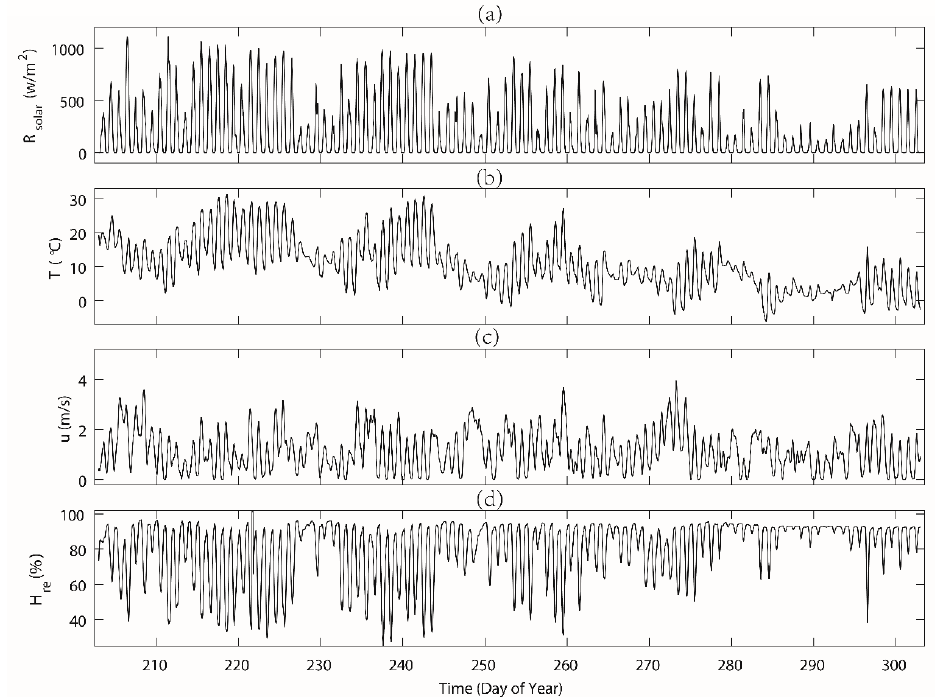
Figure 4. The measured micro-meteorological variables at hourly intervals during the day of year (DOY) 203–302 in station Rokytka (ROK). The variables including ( a ) Rs—incoming solar radiation, ( b ) T—air temperature, ( c ) u—wind speed, and ( d ) H re —relative humidity. See the exact values in